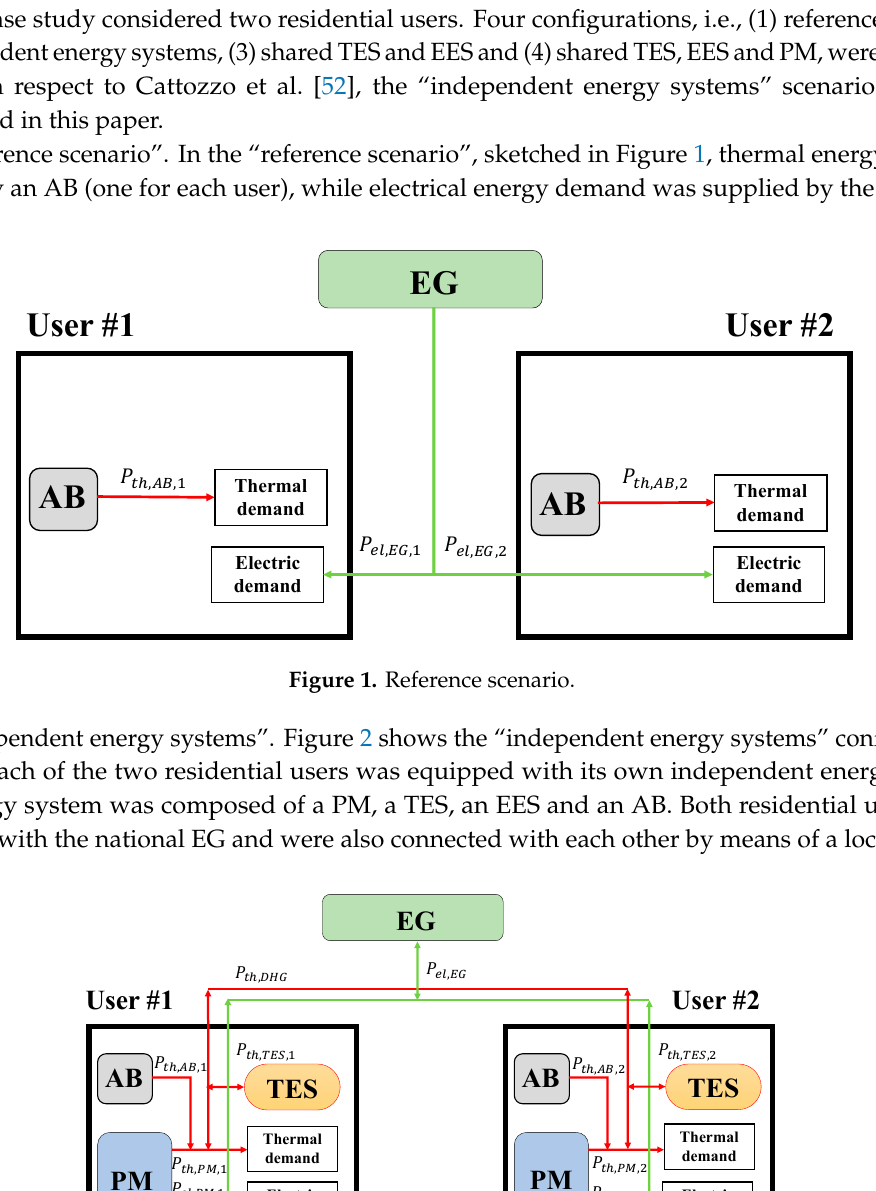
Figure 2. CHP scenario with independent energy systems.